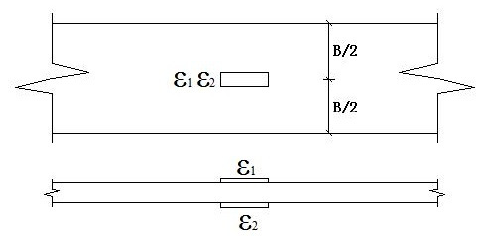
Figure 4. Strain gauge distributions of the epoxy resin matrix.